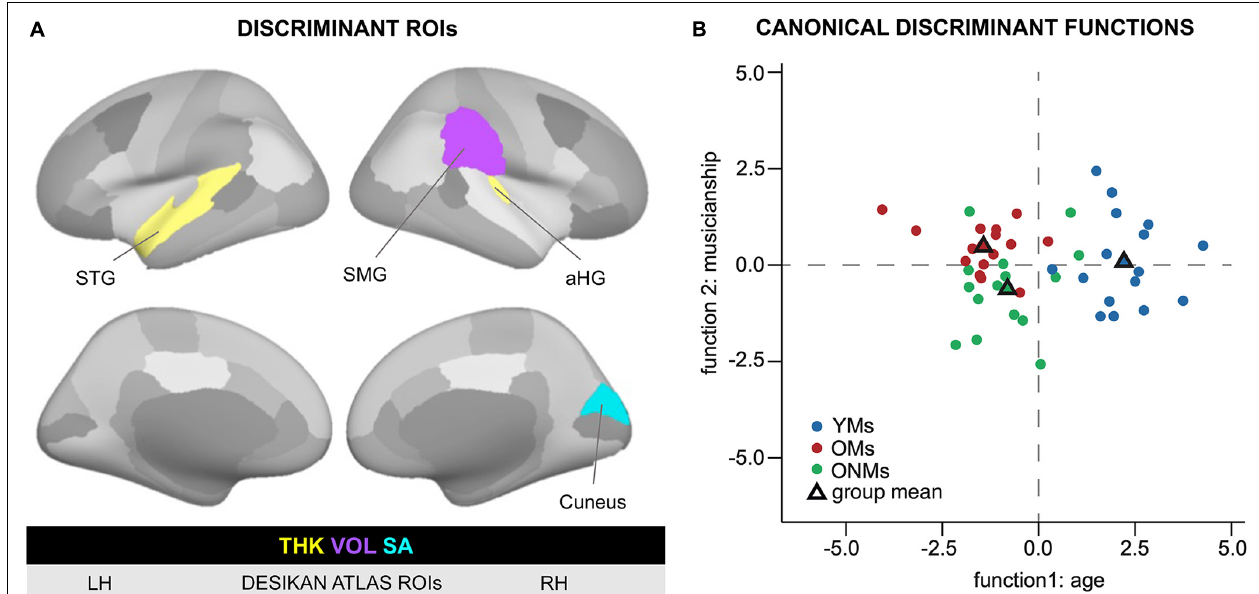
FIGURE 6 | Discriminant function analysis based on structural ROIs. ROIs that separated the groups based on structural metrics. (A) Visualization of the ROIs that resulted to be significant in the discriminant function analysis. The left and right hemispheres as well as lateral and medial views are presented based on the FreeSurfer Desikan atlas. The color code (yellow = THK, violet = VOL, and turquoise = SA) indicates the respective GM metric in the specific ROI. (B) Discriminant function analysis plot visualizing the separation between the young and old subjects on function 1 and musicians and non-musicians on function 2 based on Desikan atlas structural ROIs. For more details, see Table 4 . Based on the structural ROIs in panel A, the first discriminant function discriminated best between the OMs/ONMs and the YMs, i.e., young vs. old, while the second function differentiated the OMs from the ONMs, i.e., musicians vs. non-musicians. YMs, young musicians; OMs, old musicians; ONMs, old non-musicians; LH/RH, left hemisphere/right hemisphere; THK, thickness; VOL, volume; SA, surface area; ROI, region of interest; group mean, mean variate score for each group called centroid in the discriminant analysis; STG, superior temporal gyrus; SMG, supramarginal gyrus; aHG, anterior Heschl’s gyrus. TABLE 5 | Significant functional ROIs of the discriminant function analysis.